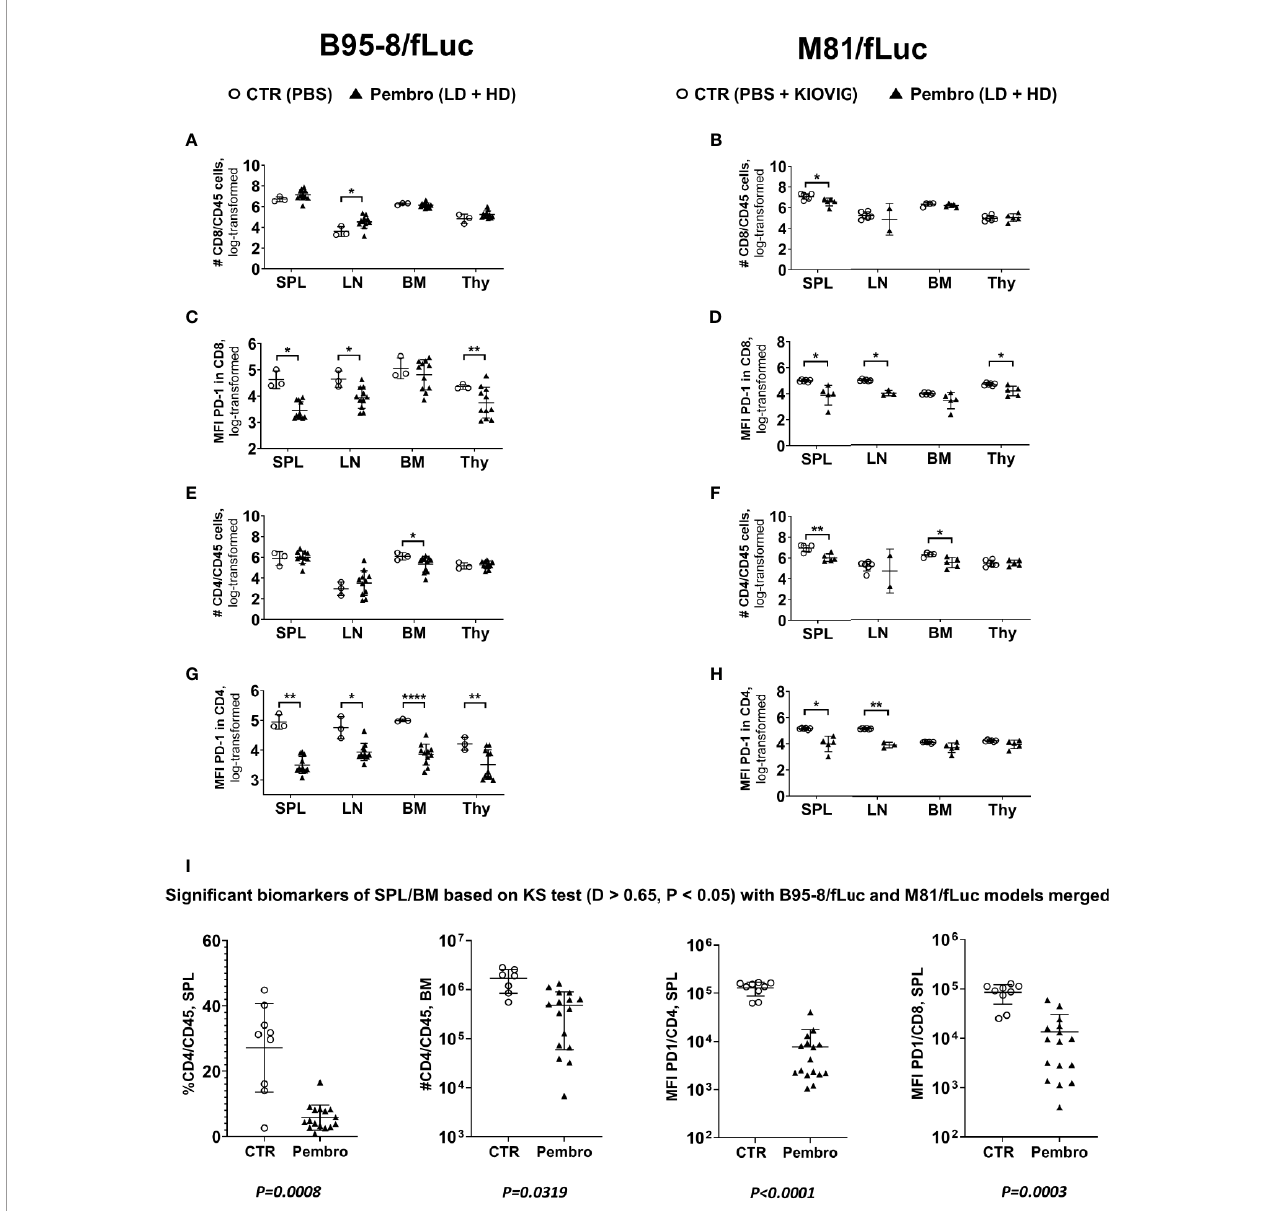
FIGURE 5 | The absolute numbers of human T lymphocytes in lymphatic tissues increased for the B95-8/fLuc model and decreased for the M81/fLuc model after PD-1 blockade. The absolute numbers of viable lymphocytes recovered from spleen (SPL), lymph nodes (LN), bone marrow (BM), and thymus (Thy) were counted and, after fl ow cytometry analyses, the absolute numbers of each lineage was calculated. Non-treated control mice (CTR, open circles) and pembrolizumab-treated cohorts are shown ( fi lled triangles; low-dose and high-dose treatments were merged for the analyses; each dot represents a mouse analyzed at the terminal time point). Only mice surviving until the terminal analyses at 8 wpi were included in the terminal fl ow cytometry analyses. (A, B, E, F) . Quanti fi ed total lymphocyte numbers (# cells) calculated for CD8 + T cells (A, B) and CD4 + T cells (E, F) for each organ. Note the increased numbers of lymphocytes for the B95-8/fLuc models and the decreased numbers for the M81/fLuc models for the pembrolizumab-treated mice. (C, D, G, H) Mean fl uorescence intensity (MFI) for PD-1 detection for CD8 + T cells (C, D) and CD4 + T cells (G, H) showing overall signi fi cantly reduced PD-1 detection after pembrolizumab treatment for both models. Unpaired t test with Welch ’ s correction was used to compare treatment groups. *P < 0.05, **P < 0.01, ****P < 0.0001 . Standard deviation is indicated. (I) Global power analyses and biomarker identi fi cation. The fl ow cytometry datasets of spleen of B95-8/fLuc and M81/fLuc models were merged. Kolmogorov-Smirnov Test (KS test; D > 0.65, P < 0.05 ) is depicted. The biomarkers identi fi ed with signi fi cant differences between control (CTR, open circles) and pembrolizumab treatment (Pembro, fi lled triangles) were: Lower SPL % CD4/CD45 ( P = 0.0008 ); lower BM #CD4/CD45 ( P = 0.0319 ); lower MFI for PD-1 in CD4 + cells ( P < 0.0001 ); lower MFI for PD-1 in CD8 + cells ( P = 0.0003 ). P-values determined for each marker are indicated below the